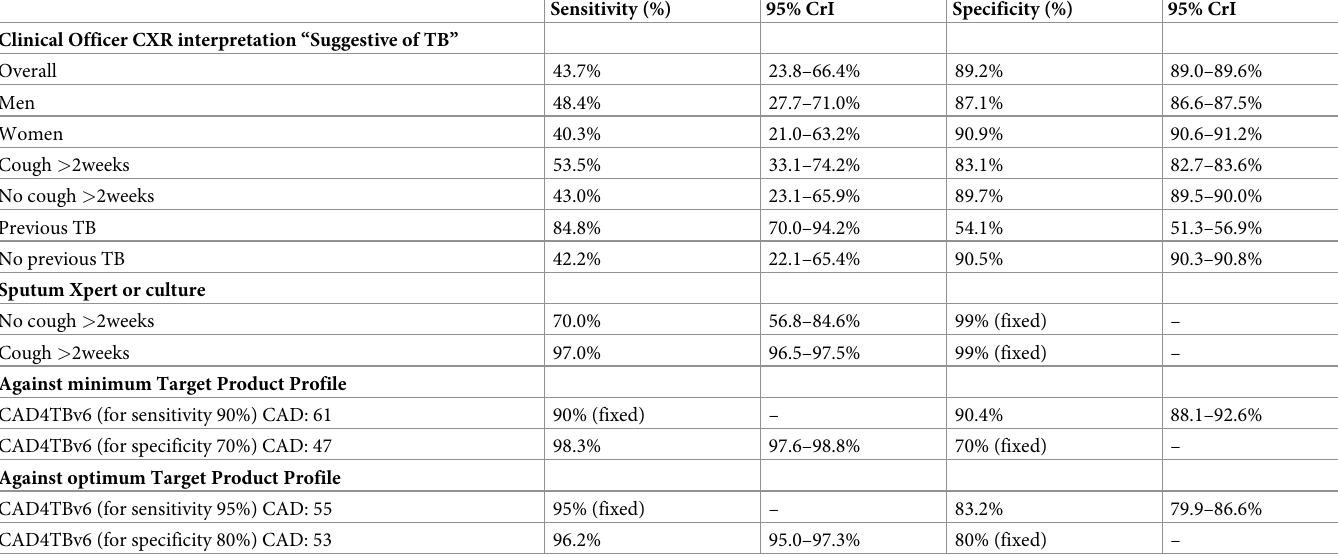
Table 2. Model-based accuracy of screening and diagnostic tests per category compared to the modelled true